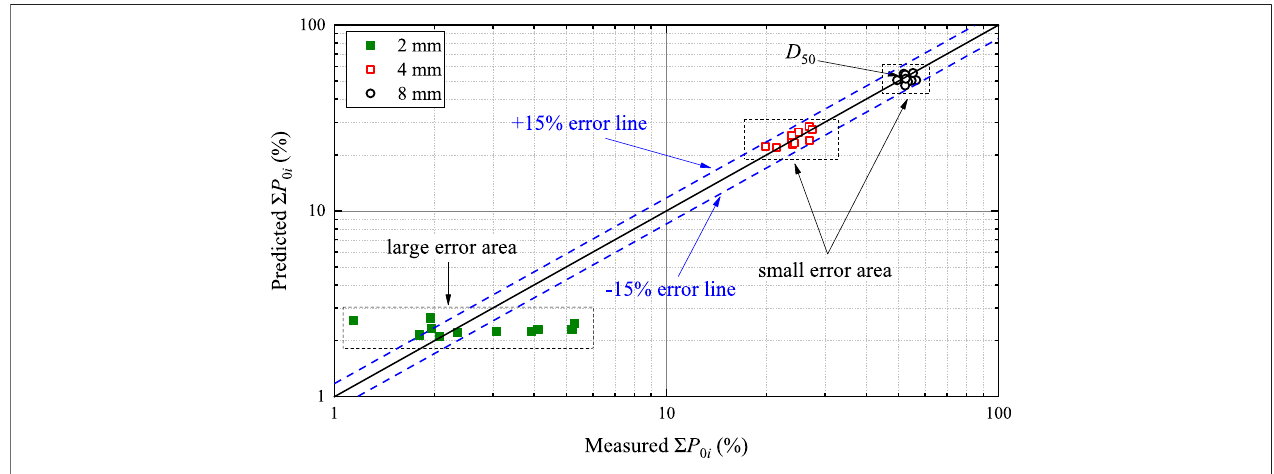
FIGURE 7 | Comparison of particle diameter cumulative percentage model predictions and actual measurement values from different